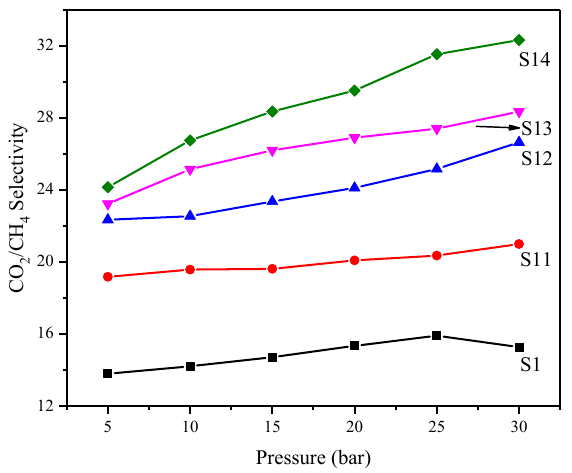
Figure 10. Effect of feed pressure on the selectivity of PES/modified silica MMMs.